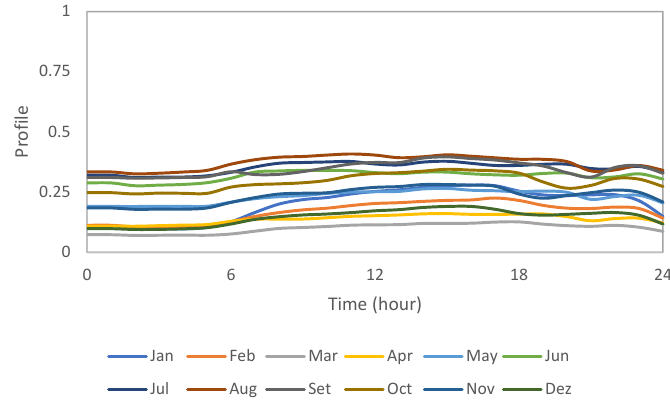
Figure A7. Average daily profile of electricity generation from natural gas, per month.